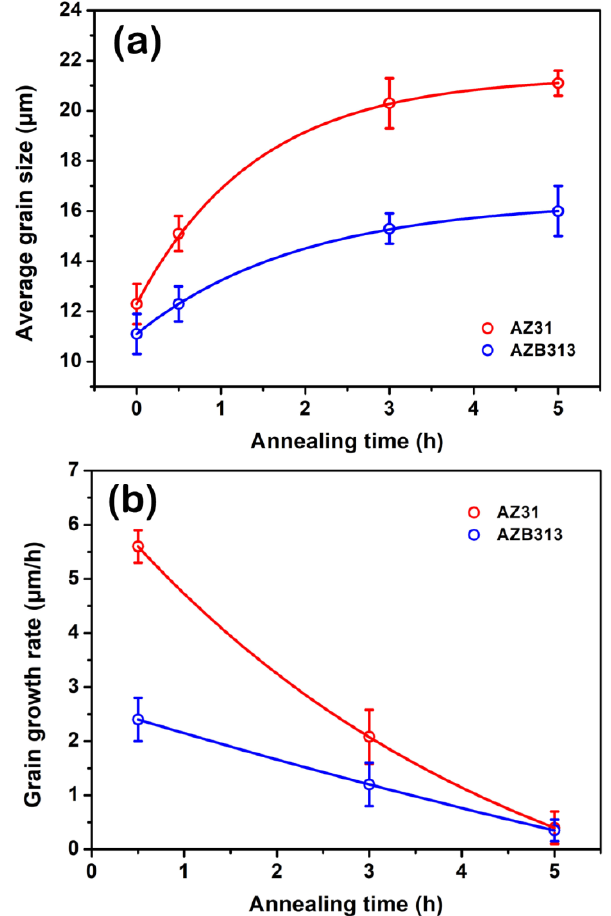
Figure 8. ( a ) Average grain size and ( b ) grain growth rate as a function of annealing time during high-temperature annealing in two as-extruded alloys.